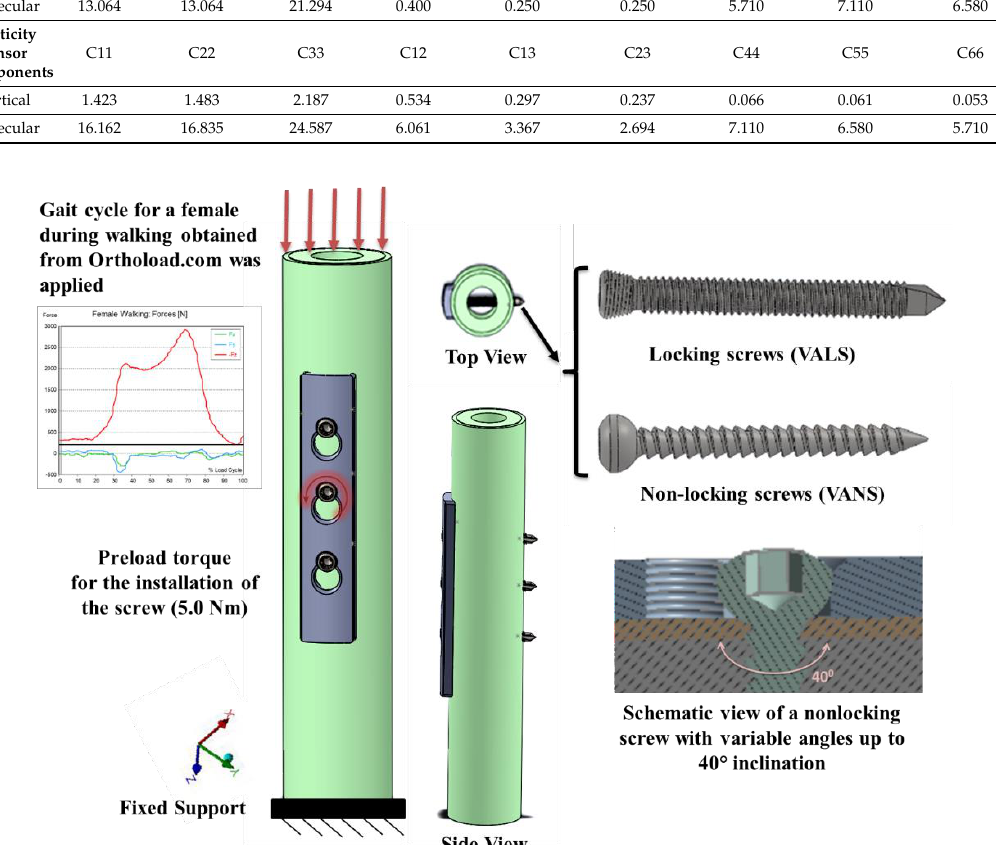
Figure 5. The 3D model of the bone, plate, and screws. Schematic view of a nonlocking screw with variable angles up to 40° inclination. Gait cycle for a female during walking obtained from Orthoload.com.